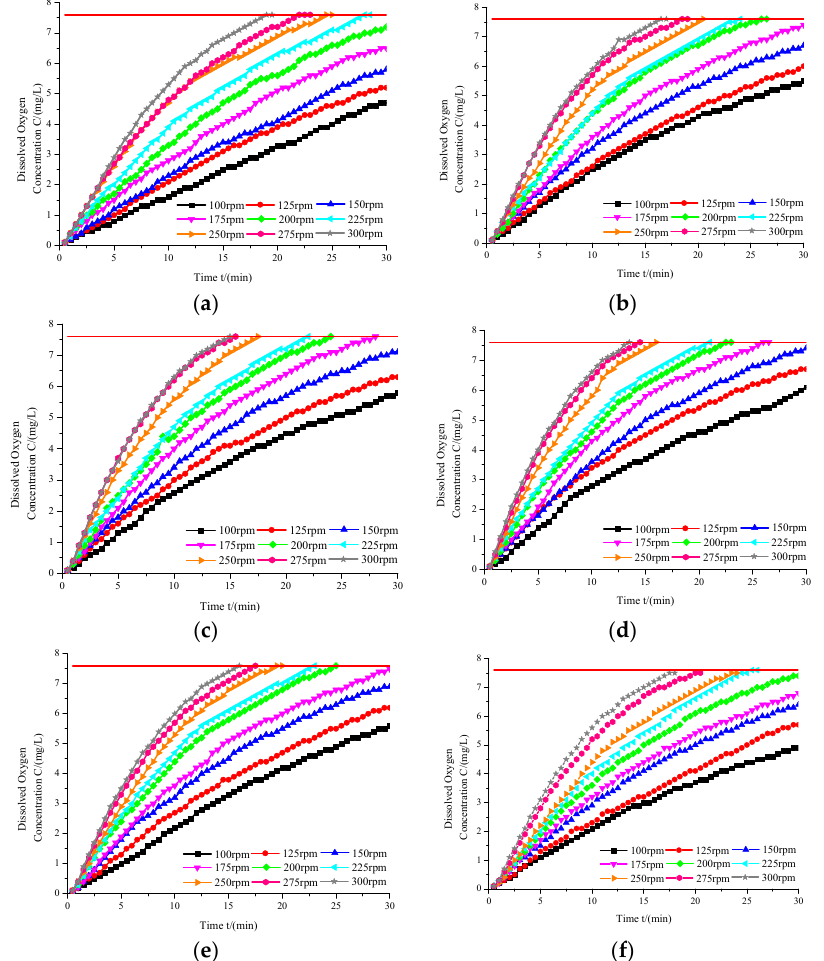
Figure 4. Dissolved oxygen concentration at different immersion depths. ( a ) +10 mm; ( b ) +5 mm; ( c ) 0 mm; ( d ) −5 mm; ( e ) −10 mm; ( f ) −15 mm.